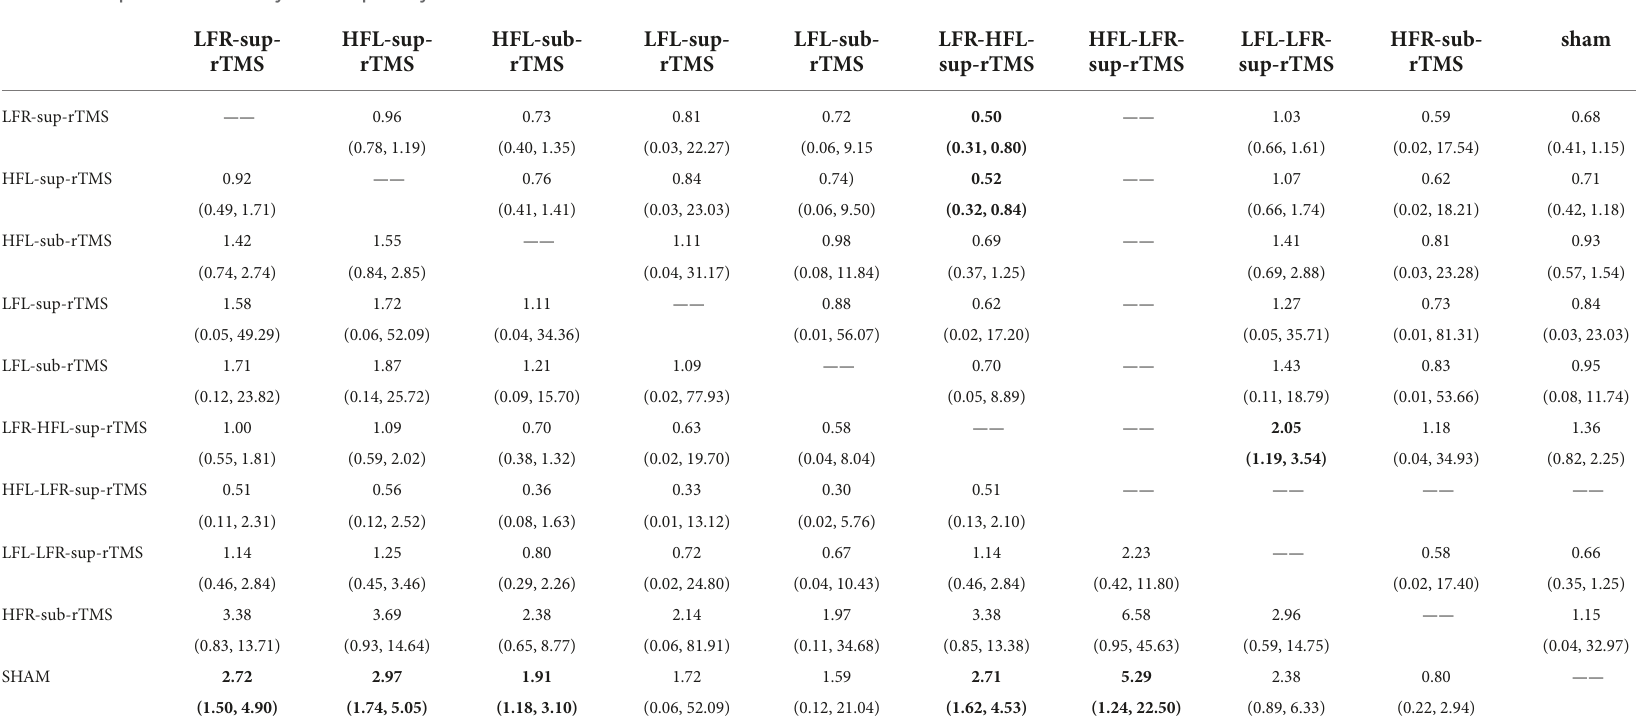
TABLE 1 Comparisons for efficacy and acceptability of